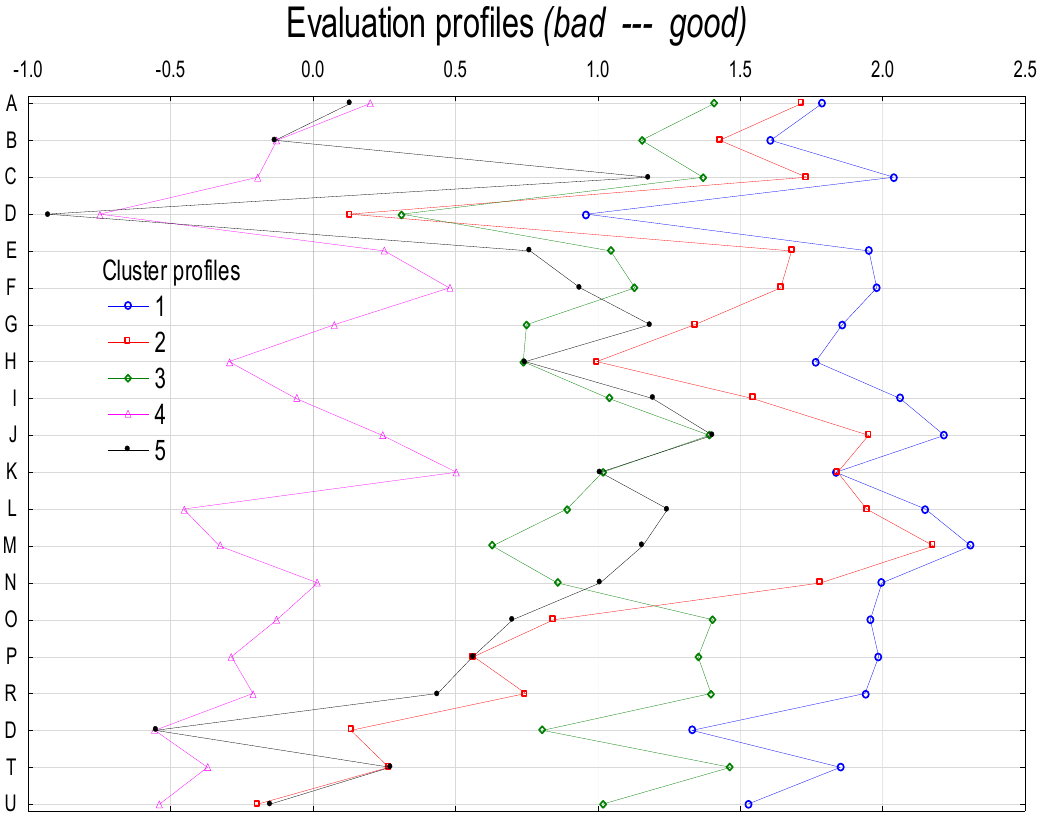
Figure 2. Profile of evaluation of service quality. Evaluation of canteen interior: A. interior design, B. equipment attractiveness, C. establishment atmosphere, D. music, E. table cleanliness, F. floor